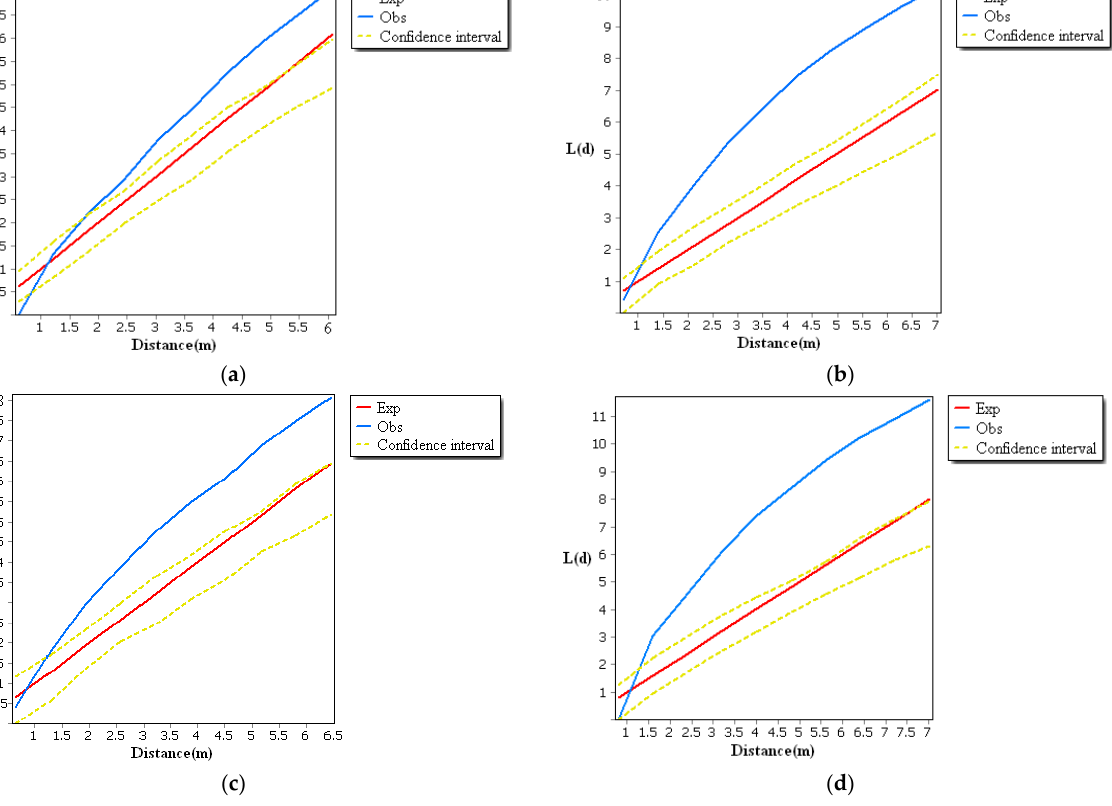
Figure 3. Spatial point pattern of root sprouts of Malus sieversii, ( a ) Analysis of the spatial pattern of root sprouting points in a typical sample area of the eastern slope; ( b ) Analysis of the spatial pattern of root sprouting points in a typical sample area of the southern slope; ( c ) Analysis of the spatial pattern of root sprouting points in a typical sample area of the western slope; ( d ) Analysis of the spatial pattern of root sprouting points in a typical sample area of the northern slope.